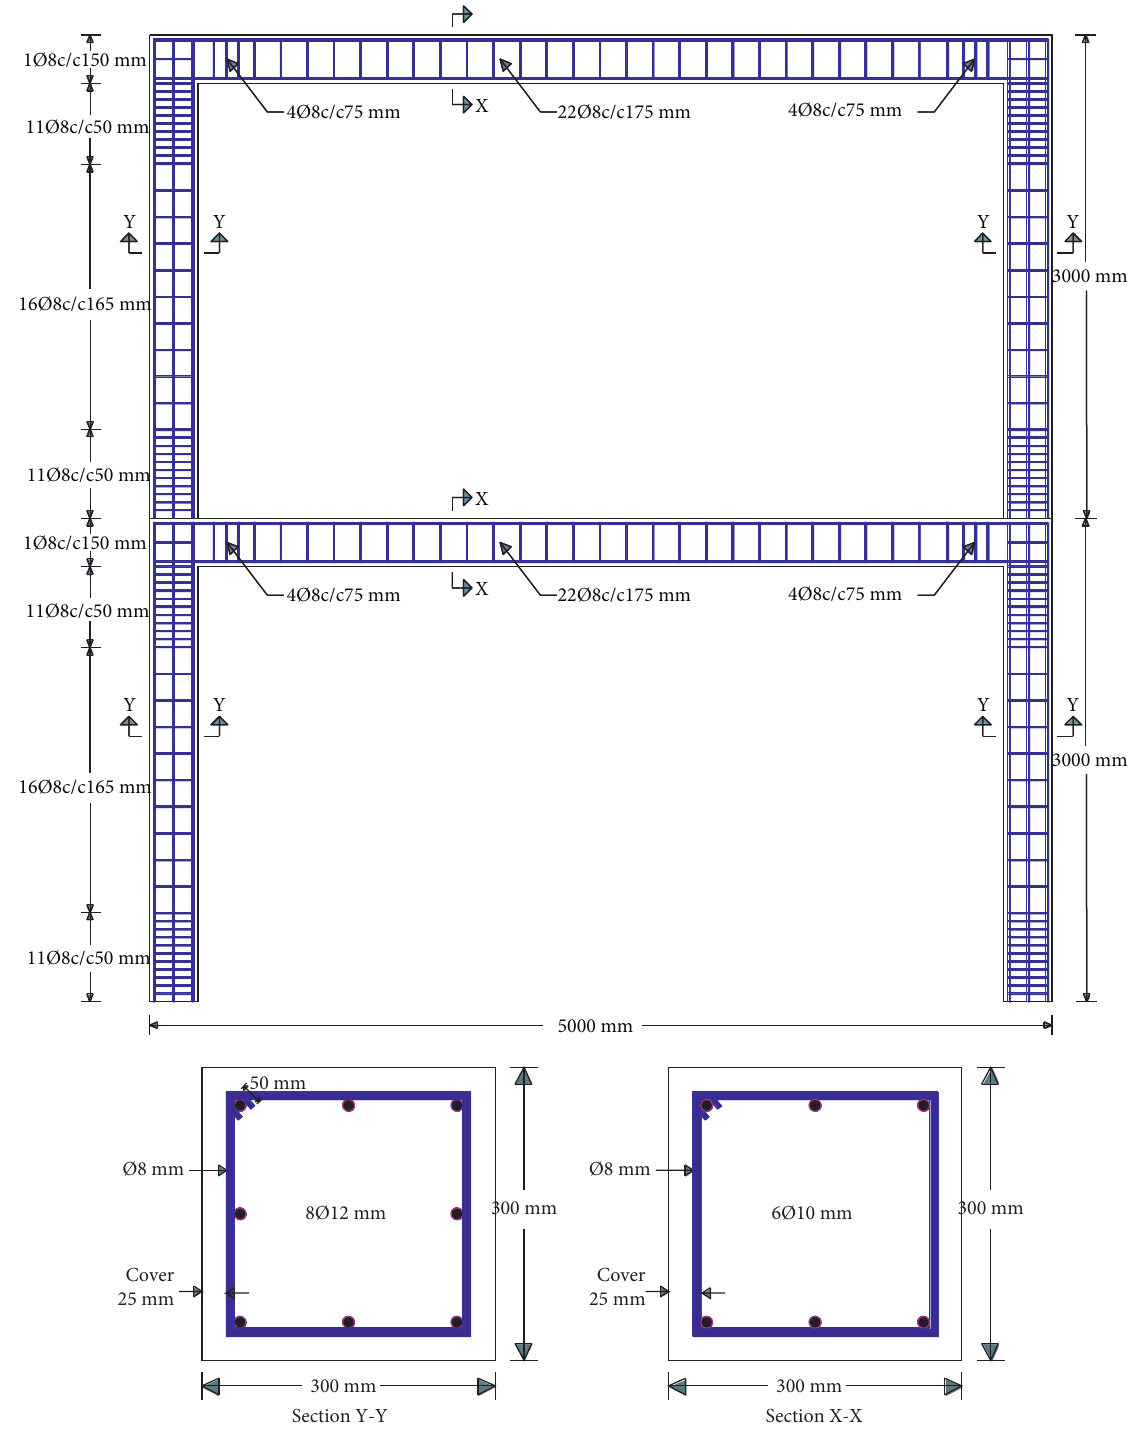
Figure 10: Reinforcement detailing for